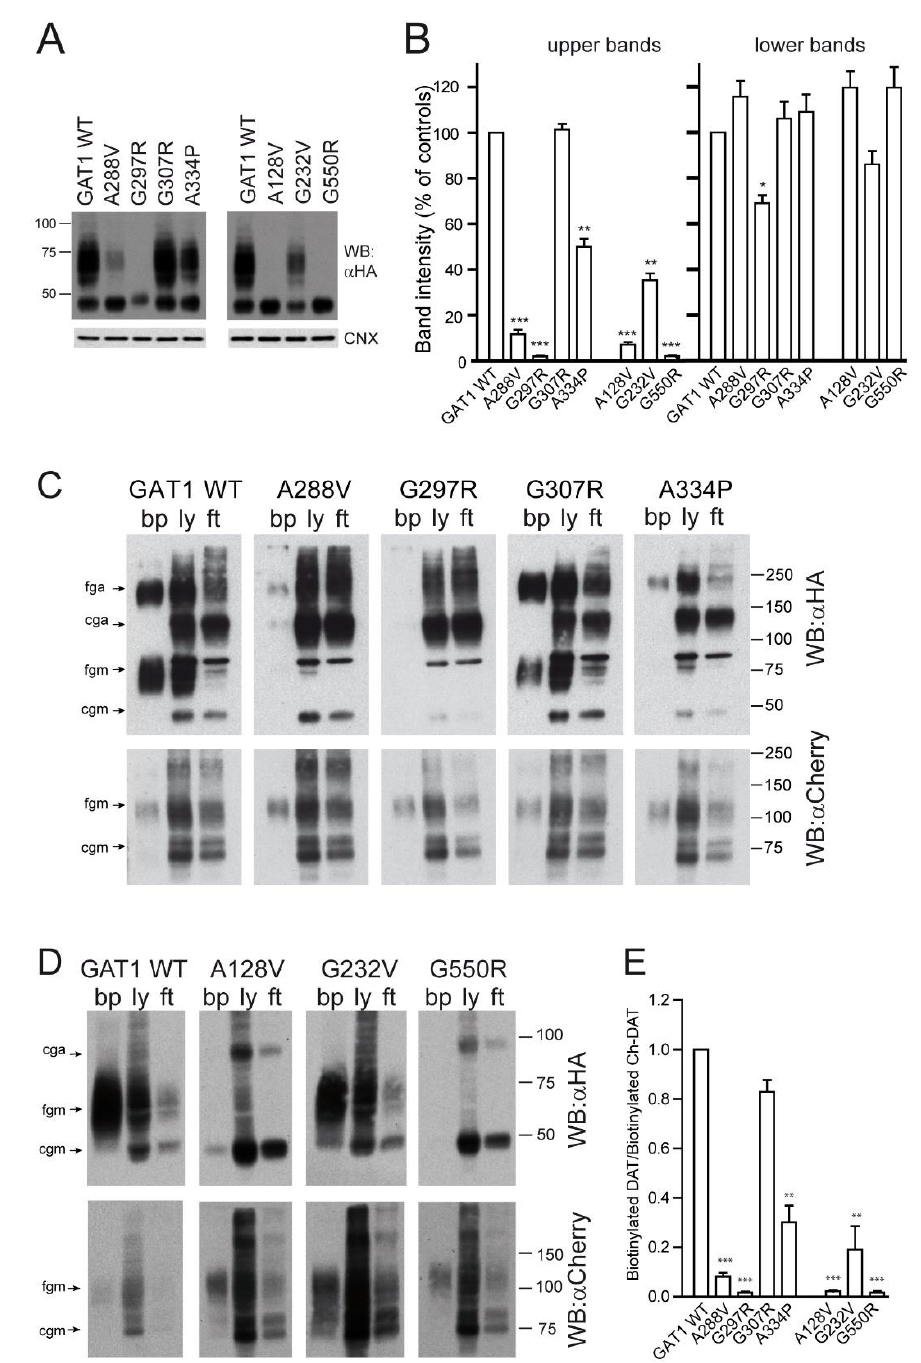
Figure 3. Expression of GAT-1 variants in transfected HEK293 cells. ( A ). HEK293 cells were transfected with the indicated variants of GAT-1 as indicated in Figure 2. Cell were lysated and samples were analyzed by western blot using anti-HA antibody and anti-calnexin as a loading control. ( B ). Densitometric analysis of the fully (upper) and the core glycosylated (lower) bands expressed as percentage of the GAT-1 WT variant. Values are the mean ± SEM of four experiments. *: p < 0.01; **: p < 0.005; ***: p < 0.001, paired t -test. ( C , D ). Biotinylation assay. HEK293 cells were co-transfected with mCherry-DAT plus either GAT-1 WT (control) or the indicated variants. Two days later, cell surface proteins were labeled with sulfo-NHS-biotin. Biotinylated proteins were separated from non-biotinylated ones with streptavidin-agarose beads and eluted from the beads. Samples of bio- tinylated protein (bp), lysate (ly) and flow through (ft) were resolved by SDS-PAGE and analyzed by immunoblotting with anti-HA antibodies, and reprobed with anti-mCherry antibodies. The